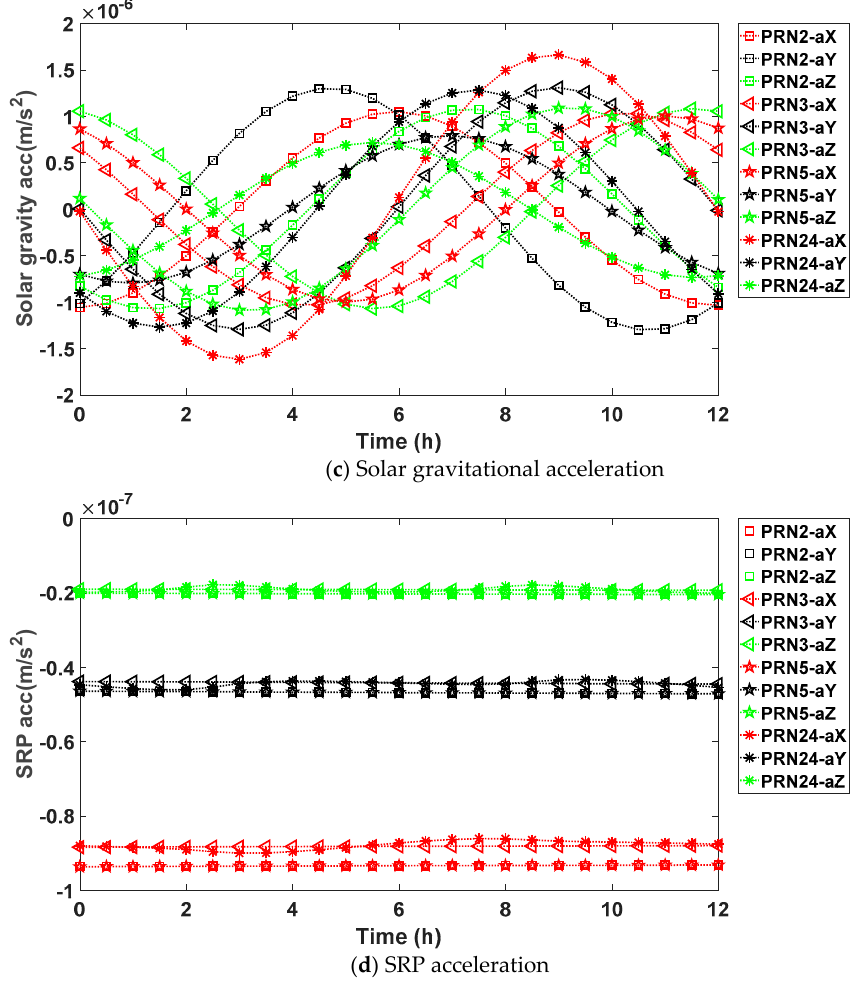
Figure 2. Earth gravitational acceleration, lunar gravitational acceleration, solar gravitational acceleration, and SRP acceleration over one day for GPS satellites PRN2, PRN 3, PRN 5, and PRN 24.